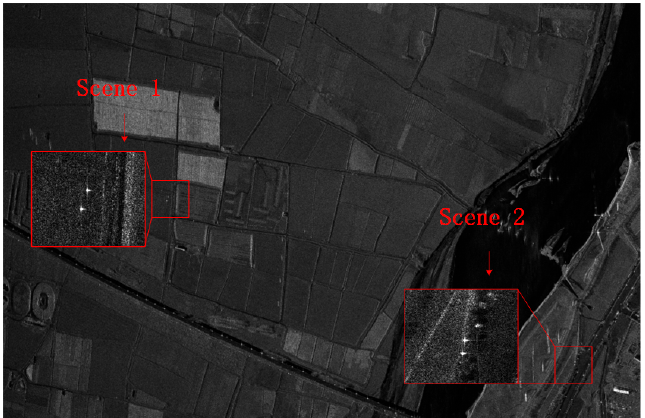
Figure 11. Layover points 2D SAR imaging.